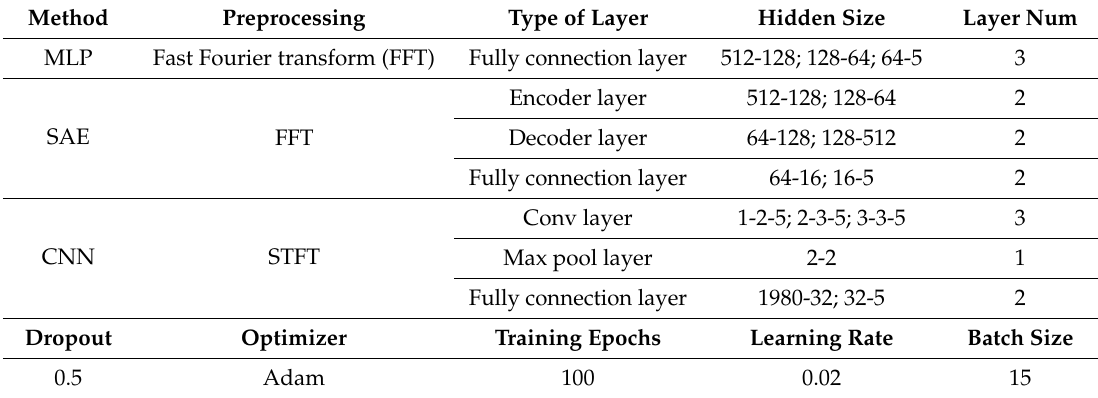
Table 4. Thedetailsofhyper-parametersandmodelarchitecturesinthedeepneuralnetwork(DNN)methods.